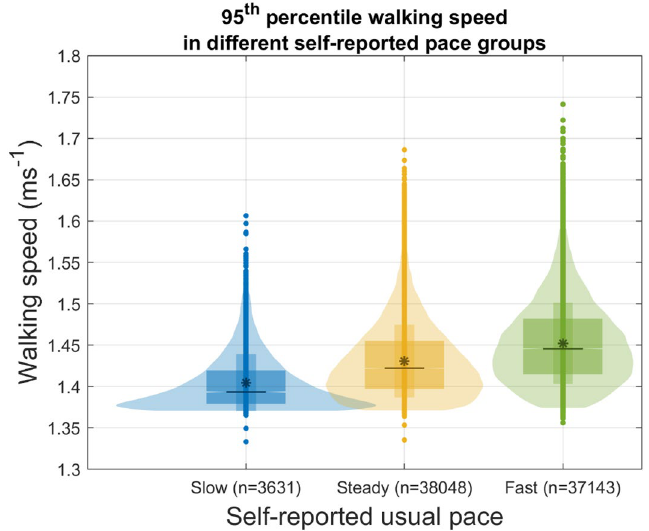
Figure 4. Maxmial walking speed for people who reported slow, steady and brisk walking paces. N = 78,822. Individual dots at the upper and lower extreme, raw data outliers. Widths of the violin plots, kemel desnsities; Top and bottom of the violin plots, 1st and 99th percentiles; Top and bottom of the narrower boxs, mean ± standard deviation; Top and bottom of the widers box, 1st and 3rd Quartile; Notches of the wider box, 95% confidence intervals of the population median; Black lines in the middle of the boxs, group medians; The asterisks in the middle of the boxes, group